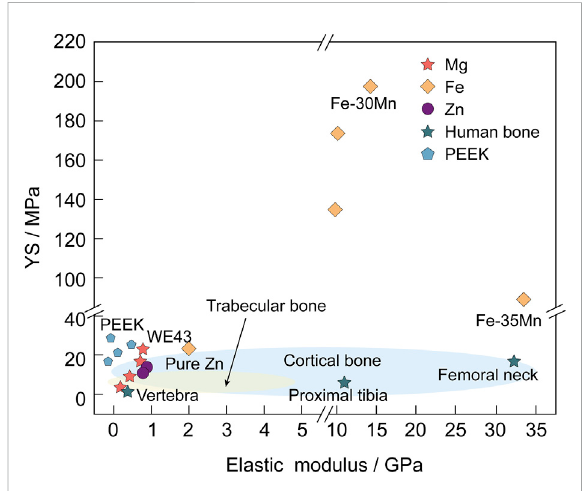
FIGURE 1 YS (MPa) and elastic modulus (GPa) of Mg and its alloys are more similar to natural bone than those of other biodegradable metallic materials (such as Fe and Zn) and Polyetheretherketone (PEEK) (Chen et al., 2022; Wang et al.,